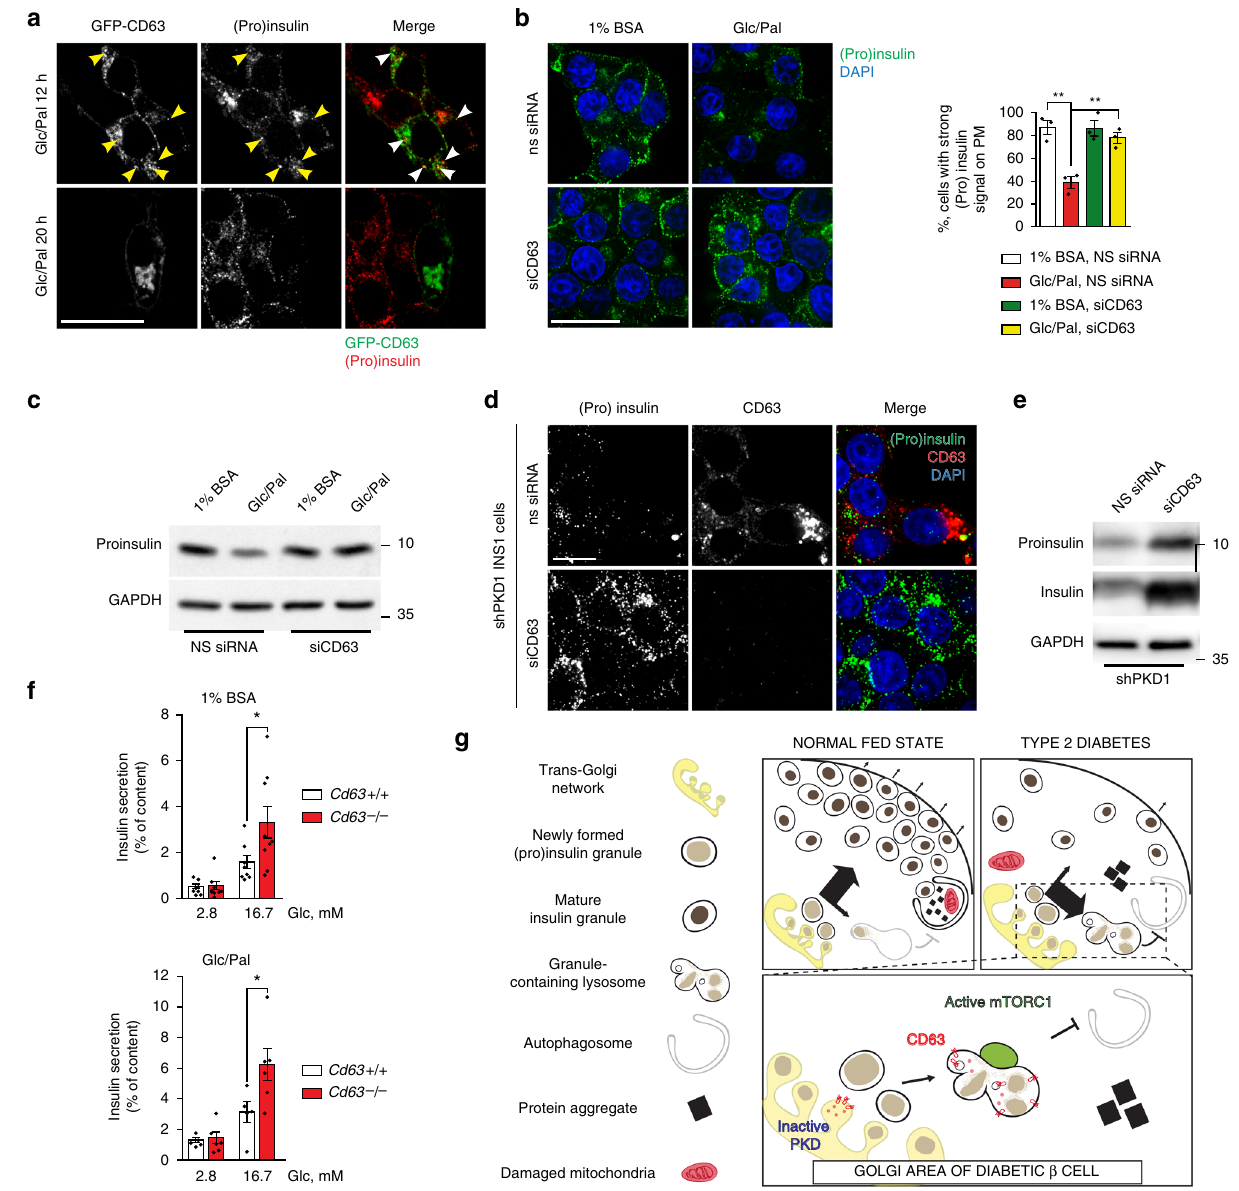
Fig. 5 Stress-induced nascent granule degradation requires CD63. a Immuno fl uorescence (IF) of insulin + proinsulin ( ” (pro)insulin ” ) (red) in INS1 cells overexpressing GFP-CD63 (green) and treated with control (1% BSA, 11 mM glucose, “ 1% BSA ” ) or glucolipotoxic (1% BSA, 33.3 mM Glucose and 0.4 mM Palmitate, “ Glc/Pal ” ) media for the indicated time. Arrowheads point to GFP-CD63/(pro)insulin co-localization. Scale bar, 20 μ m. b IF of (pro)insulin (green) in INS1 cells transfected with non-silencing (ns) siRNA or siRNA against CD63 (siCD63) and treated with 1% BSA or Glc/Pal for 20 h. Scale bar, 20 μ m. Quanti fi cation of (pro)insulin signals at the plasma membrane of INS1 cells treated as indicated. Three independent experiments ( N = 3), three fi elds per experiment per condition, n cells: 63, 62, 86, 71 respectively; ** P < 0.01, two-tailed t -test. c Immunoblot of proinsulin using lysates of INS1 cells treated as indicated. GAPDH was used as a loading control. d IF of (pro)insulin (green) and CD63 (red) in INS1 cells stably expressing shRNA against Prkd1 (shPKD1), transfected with indicated siRNAs for 48 h. Scale bar, 10 μ m. b , d Nuclei were stained with DAPI. e Immunoblot of proinsulin and insulin using lysates from INS1 cells stably expressing shPKD1, transfected with indicated siRNAs. GAPDH was used as a loading control. f Glucose stimulated insulin secretion (2.8 mM Glc and 16.7 mM Glc) of islets isolated from Cd63 + / + or Cd63 − / − mice pre-treated with control (1% BSA) or glucolipotoxic (Glc/Pal) media for 48 h. Batches of islets were independently isolated from Cd63 + / + and Cd63 − / − mice; N 1% BSA = 8 ( Cd63 + / + ), 9 ( Cd63 − / − ), N Glc/Pal =